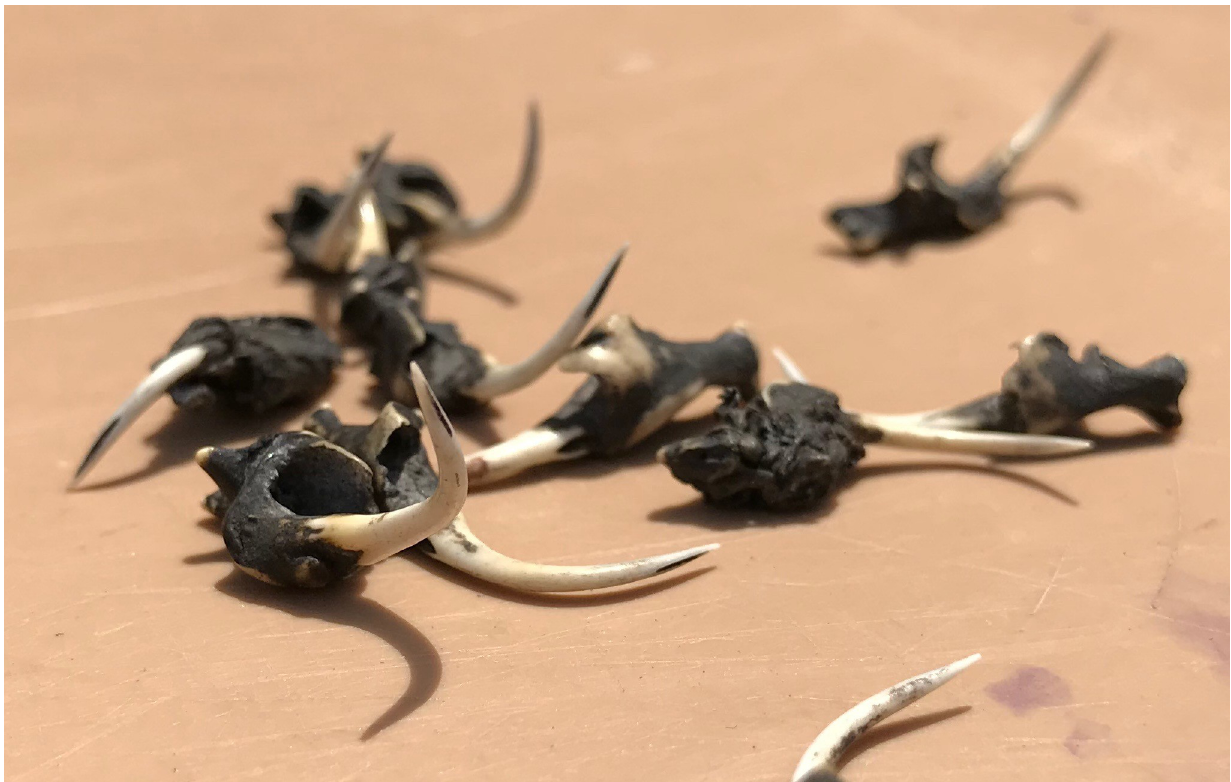
Fig 5. Snake fangs used to make incisions as part of traditional medical